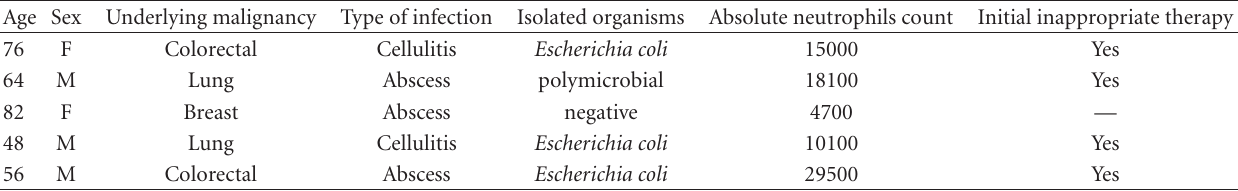
Table 5: Characteristics of 5 patients with fatal